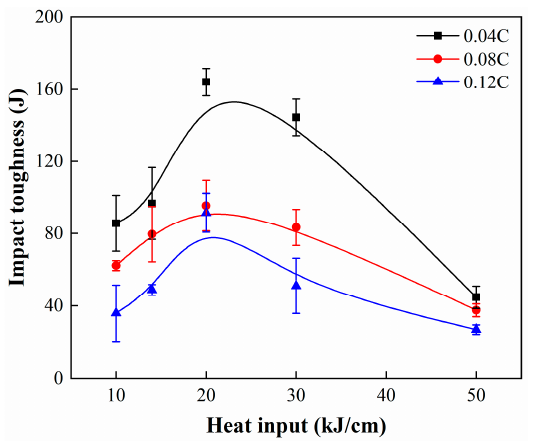
Figure 1. Charpy impact toughness of the simulated samples.